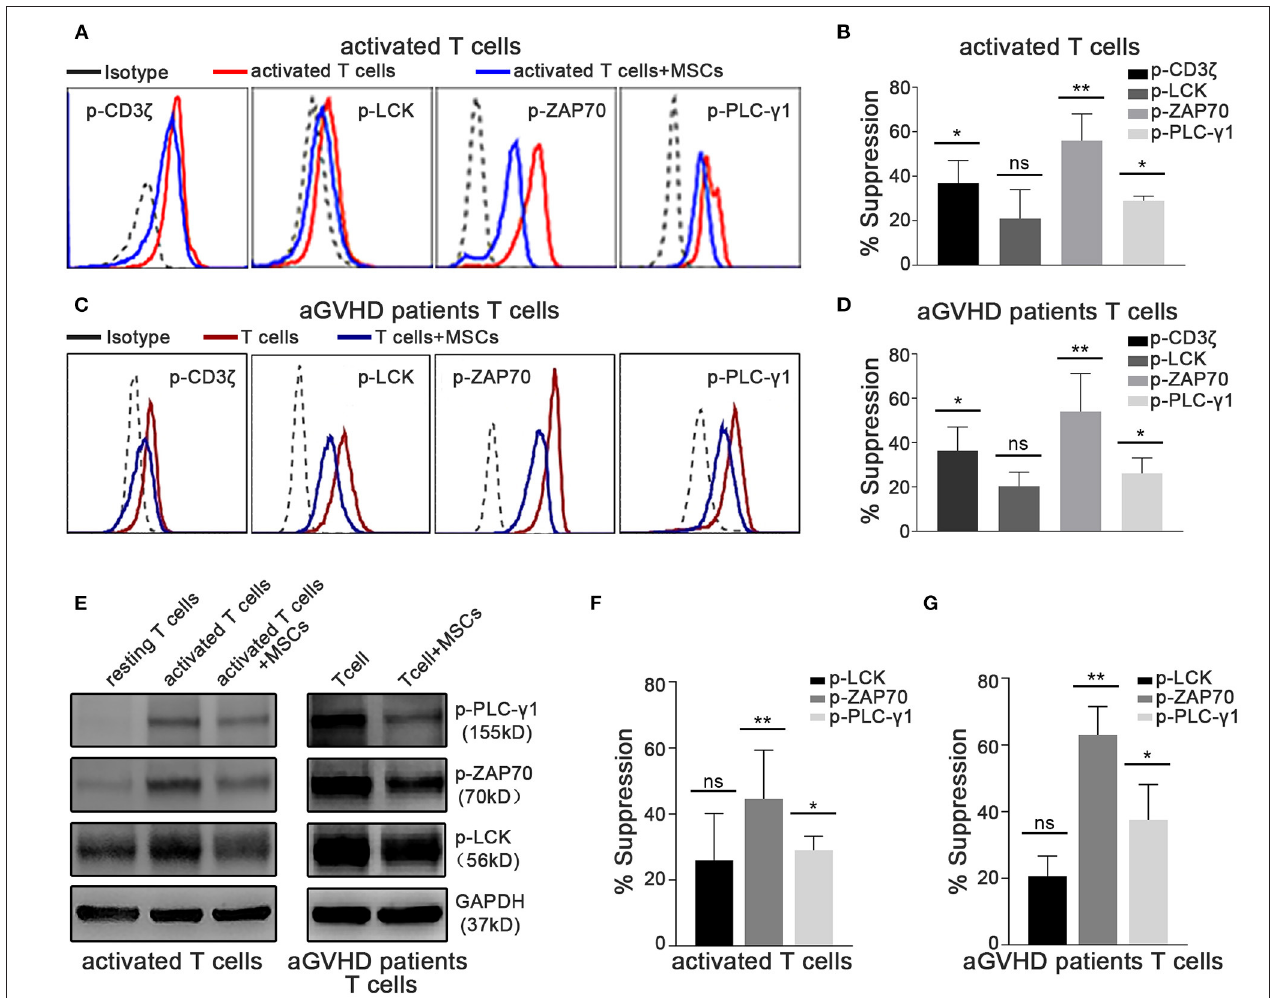
FIGURE 3 | TCR-proximal signaling is altered rapidly in activated T cells cocultured with MSCs in vitro . The phosphorylation levels of CD3 ζ , LCK, ZAP70, and PLC- γ 1 were analyzed. Cocultures were established as described for Figure 1E . (A) Flow cytometric analysis of the phosphorylation levels of CD3 ζ , LCK, ZAP70, and PLC- γ 1 in cocultured and control activated T cells from healthy donors. (B) Column chart shows the suppression percentages of the phosphorylation levels by MSCs shown in (A) . Data are presented as the means ± SEM from six donors. (C) Flow cytometric analysis of the phosphorylation levels of CD3 ζ , LCK, ZAP70, and PLC- γ 1 in cocultured and control T cells from aGVHD patients. (D) Suppression percentages of p-CD3 ζ , p-LCK, p-ZAP70, and p-PLC- γ 1 in T cells from patients after MSCs coculture. The data are presented as the means ± SEM from six patients. (E) Total cell lysates of T cells both from donors and patients were analyzed via western blotting of the listed phosphorylated proteins, with GAPDH detected as a loading control. A representative blot is shown. (F,G) Gray-scale values of blots in (E) were analyzed, the suppression percentages of listed phosphorylated proteins by MSCs are shown. Data are presented as the means ± SEM from three donors. Significant differences are indicated as follows: ns, no statistical significance; * p < 0.05 and ** p <